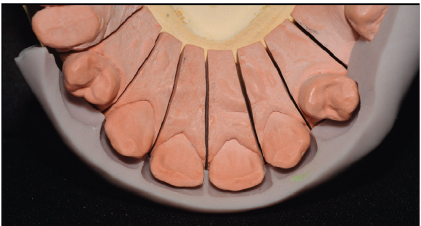
Figure 11: Silicone wall in position. The thicknesses of the ceramic laminates can be observed.